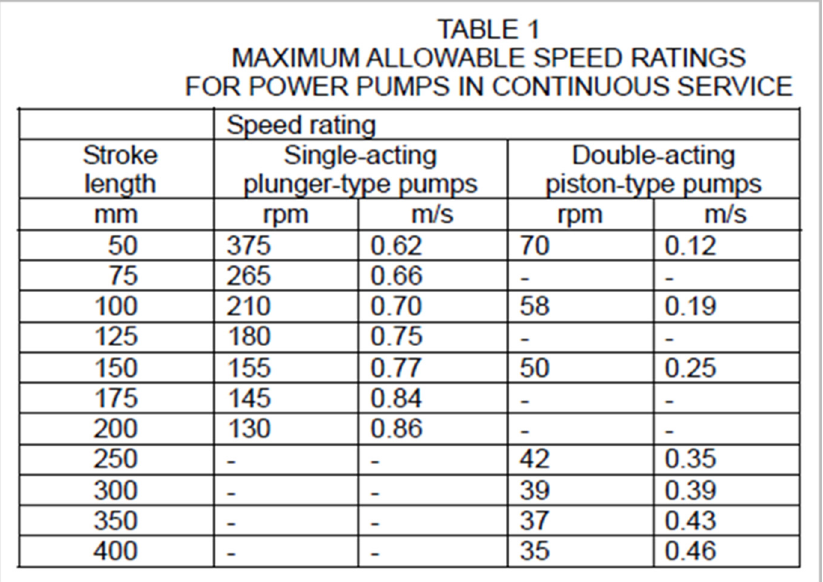
Figure 1. A table example in an engineering specification document.